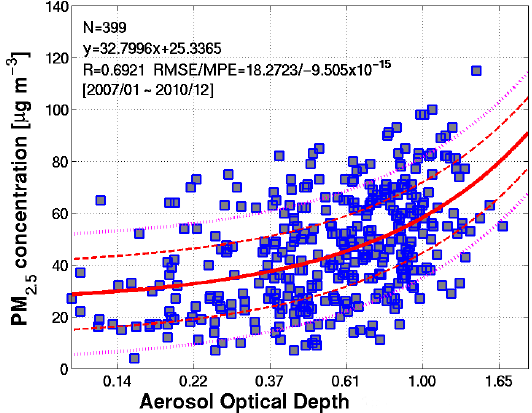
Figure 2. Scatter plot of collocated National Aeronautics and Space Administration (NASA) Earth Observing System (EOS) Terra MODIS-derived aerosol optical depth (AOD) at the wavelength of 0.55 μ m ( x -axis) against ground-based PM 2.5 levels ( y -axis). Both data sets were processed from 2007 to 2010 in the study area. Please refer to the text for the detailed collocation procedure. The x -axis and y -axis are represented in logarithmic and linear scales, respectively. The cross-validation statistic results of the empirical statistical model (solid red curve) are shown in the upper left corner. The dashed red and dotted magenta curve each represents half and one standard deviation away from the evaluated values, individually. Table 1. Summary statistics of satellite-derived aerosol optical depth (AOD) and observed and estimated PM 2.5 obtained using the cross-validation (CV) technique in Taiwan for the period from 2007 to 2010. Interquartile range (IQR) is defined as the range between Q1 and Q3 in a sorted percentile. The minimum (min) and maximum (max) are the lowest and the highest value, respectively, of the given variable. The ratios between IQR and the full range are listed in the right-most column.